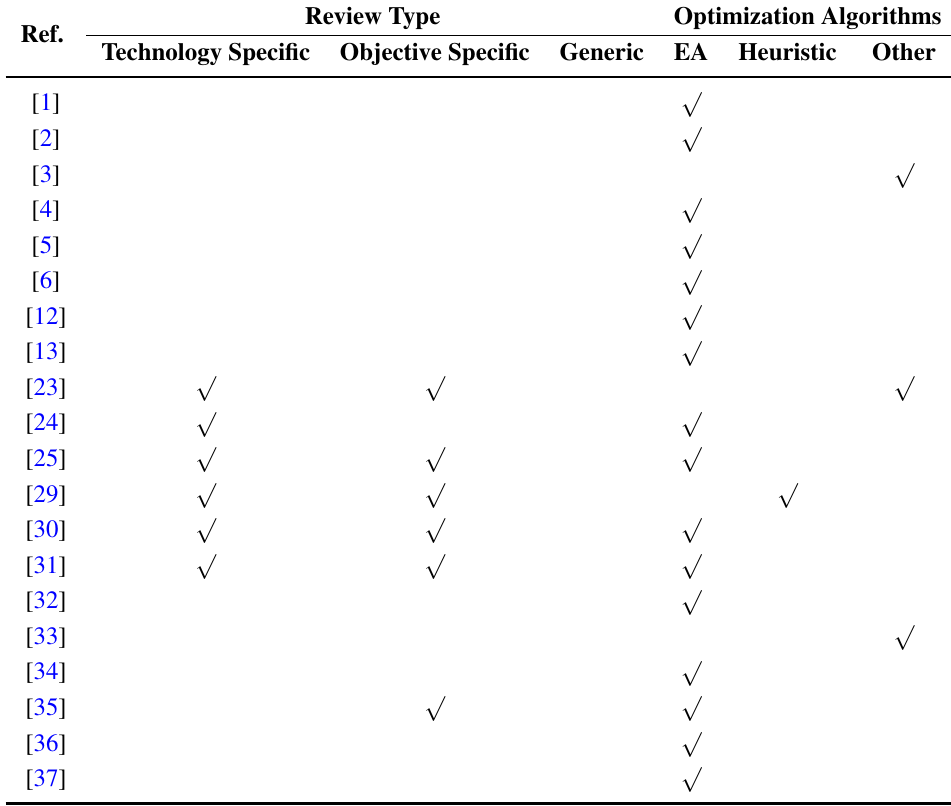
Existing reviews/surveys relating to multi-objective optimization in wireless sensor